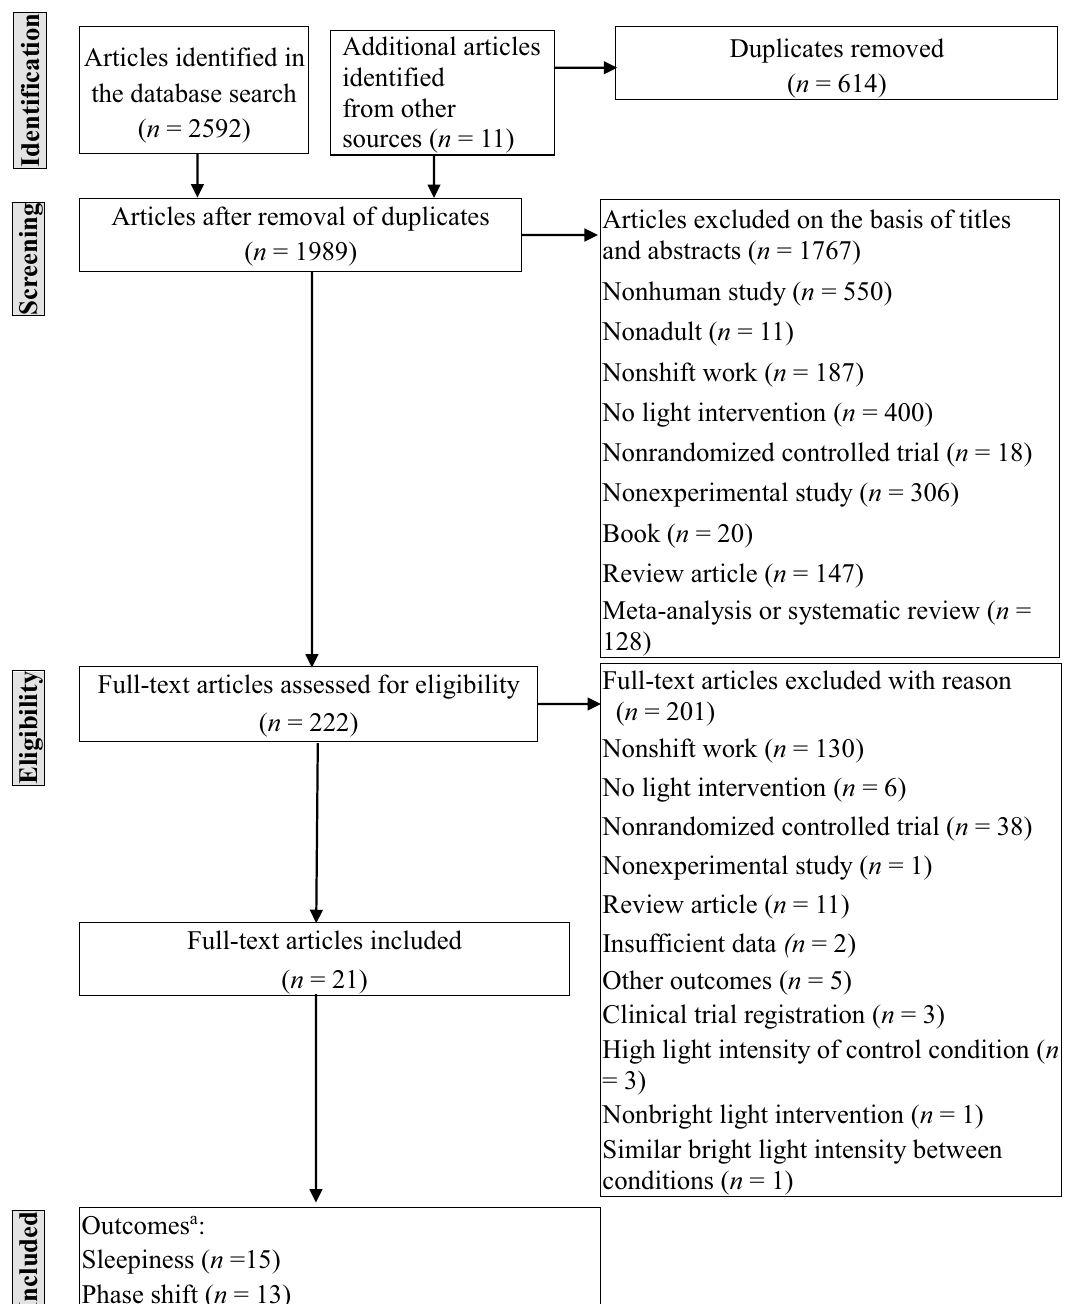
Figure 1. Flow diagram of study inclusion and exclusion in the meta-analysis a Some studies included more than one